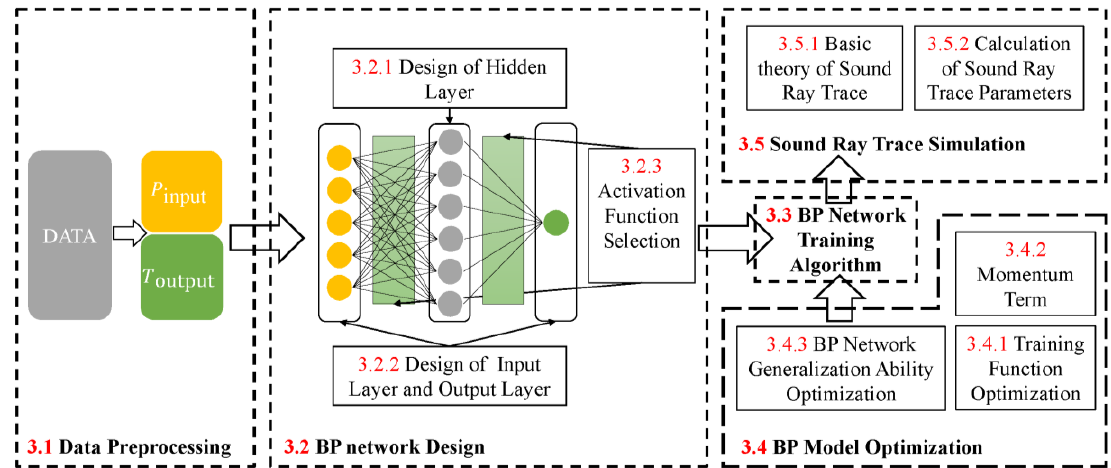
Figure 4. The structure of the methodology.